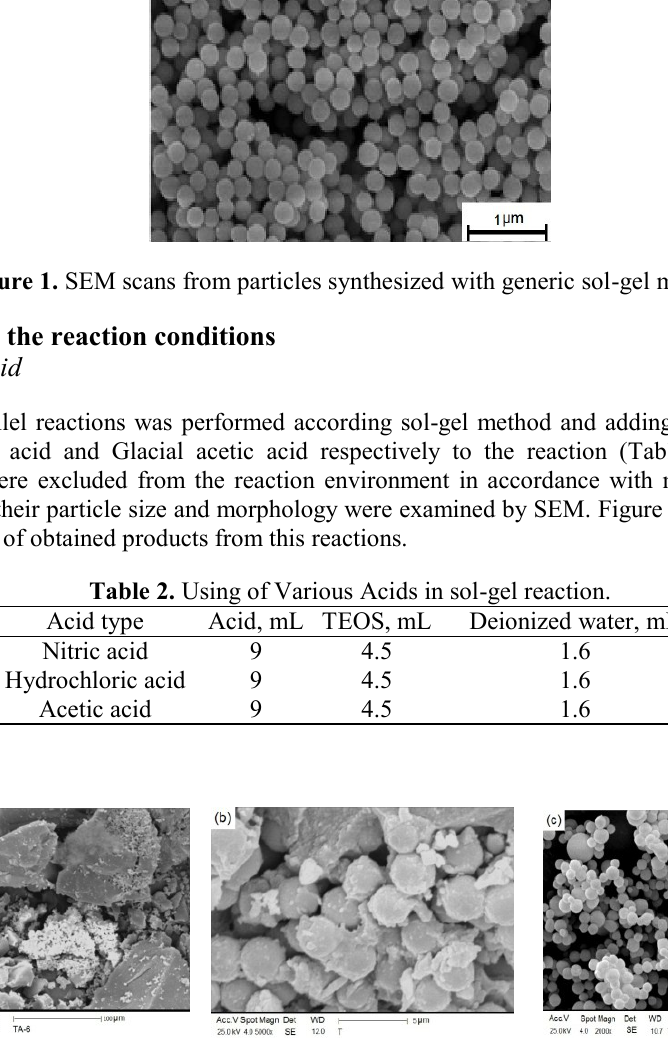
Figure 2. Synthesized particles in presence of various Acids: a) Nitric, b) Hydrochloric, c) Glacial